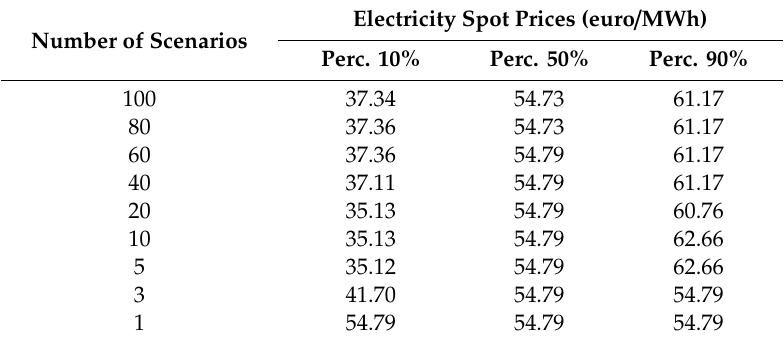
Table 4. Average 10, 50, and 90 percentiles of the probability distribution of electricity spot price for different reduced sets of scenarios.